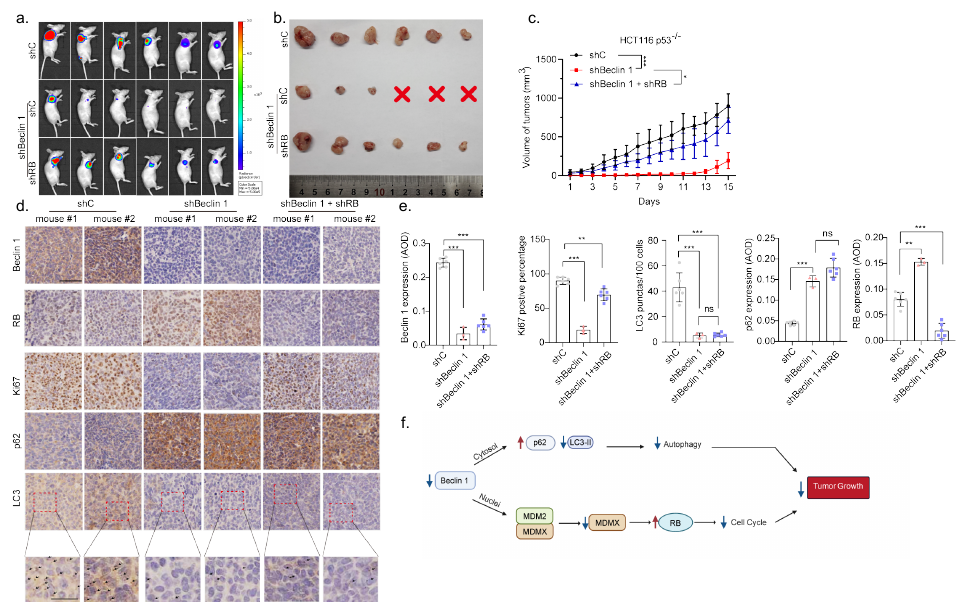
Figure 5. Knockdown of BECN1 suppresses xenograft tumor growth, which is reversed by simul- taneous ablation of RB1 . ( a ) For tumor growth assay, HCT116 p53 − / − -Antares2 cells (5 × 10 6 ) stably expressing shBeclin 1 or shBeclin 1+shRB were subcutaneously transplanted into nude mice ( n = 6/group). Diphenylterazine (DTZ) was injected into tumor regions in anesthetized mice and bioluminescence was subsequently imaged using Caliper IVIS Lumina III. ( b ) The harvested tumors were photographed. ( c ) The tumor volumes of cell-derived xenografts were determined every other day. ( d ) The tumor sections were subjected to immunohistochemistry (IHC) staining for Beclin 1, RB, Ki67, p62, and LC3 (Scale bar = 50 µ m; Inset scale bar = 10 µ m). ( e ) The respective quantification data were presented as mean ± SEM. * p < 0.05, ** p < 0.01, *** p < 0.001. ( f ) A model depicts that